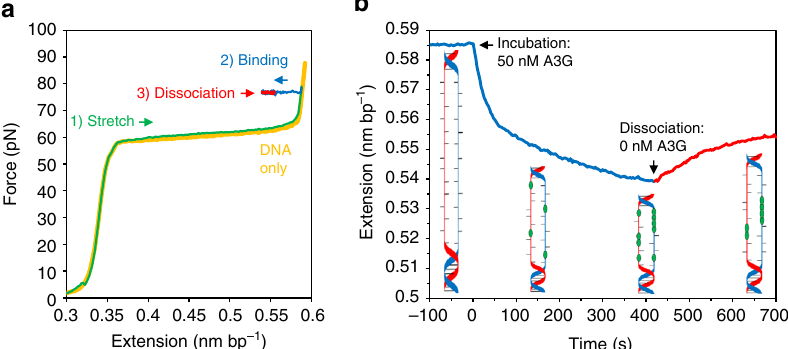
Fig. 2 Measuring A3G binding to ssDNA using optical tweezers. a A single dsDNA molecule is stretched until reaching a tension of 80pN (1). Above ~60 pN, a force induced melting transition creates two ssDNA strands. A3G is fl owed into the sample allowing for binding to ssDNA, (2) whereas active force feedback maintains constant force. After a set incubation time, buffer without A3G is fl owed into the sample, resulting in unbinding of some of the bound A3G (3). b A3G begins to bind ssDNA, resulting in a shortening of the DNA extension at time 0 s ( blue ). At time 400 s, buffer replaces the A3G and some fraction of the A3G dissociates, resulting in an increase in extension ( red